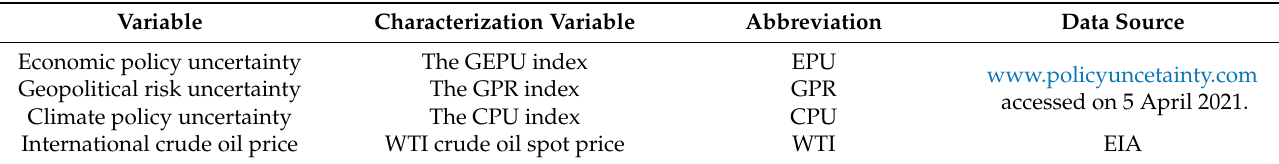
Table 1. Variable selection and data sources.